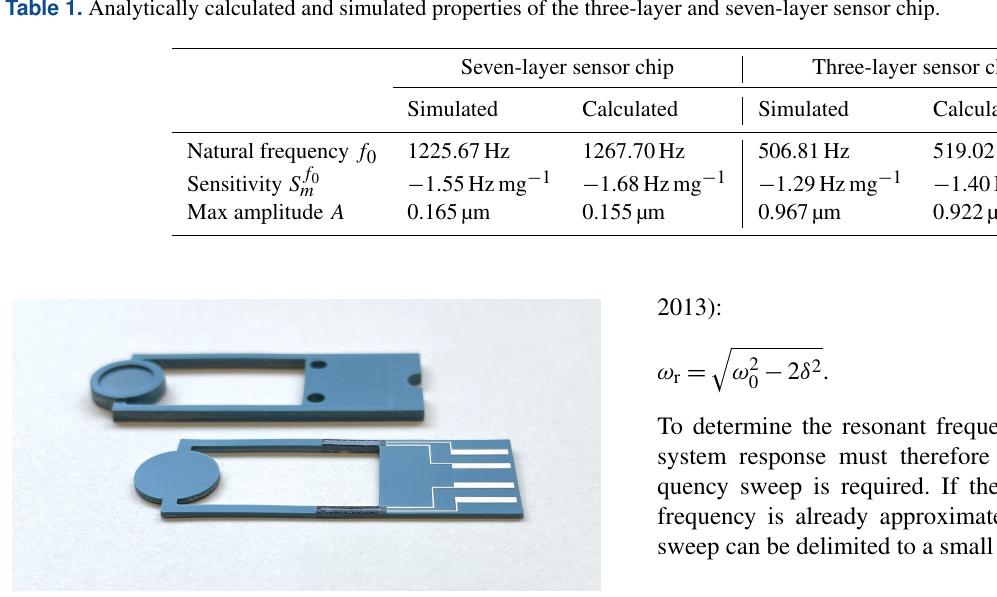
Figure 4. Comparison of sensor chip geometries (width × height: 13 × 40mm): seven-layer chip (thickness t = 1 . 45mm) in the back- ground and three-layer chip (thickness t = 0 . 6mm) with screen- printed strain gauges and leads in the